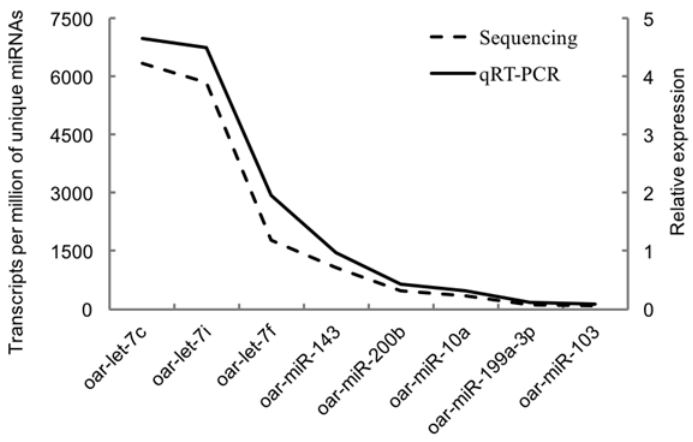
Figure 5. Validation results of the selected miRNAs by quantitative RT-PCR.